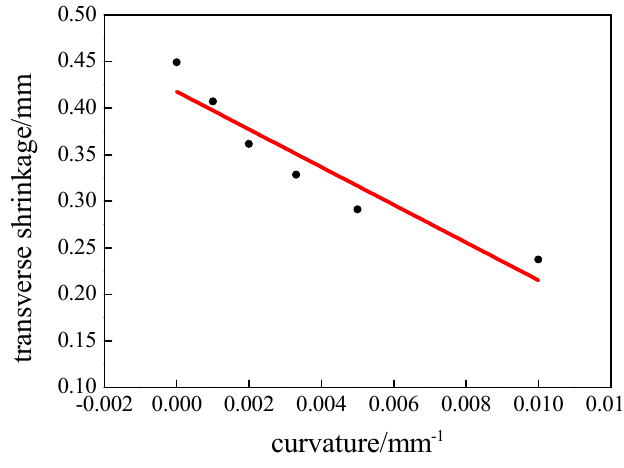
where C curvature is the transverse curvature of the weld.